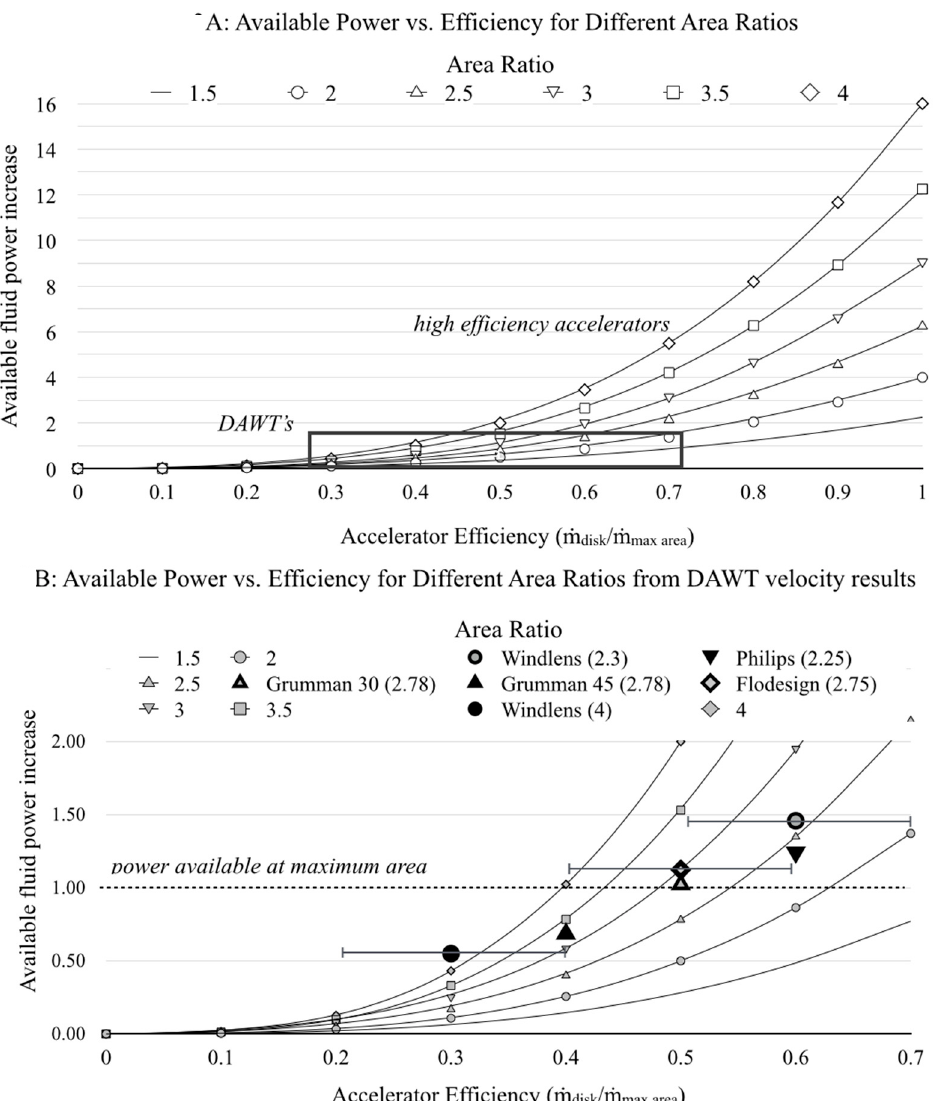
Figure 3. Baseline DAWT Fluid power at throat related to maximum area power ratio. Estimates are based on published / claimed C P . These estimates are may contain errors due to incomplete reporting of performance. (n) Denotes Area Ratio. Phillips [13], Grumman [16], Wind Lens [19], Flodesign/Ogin [18].